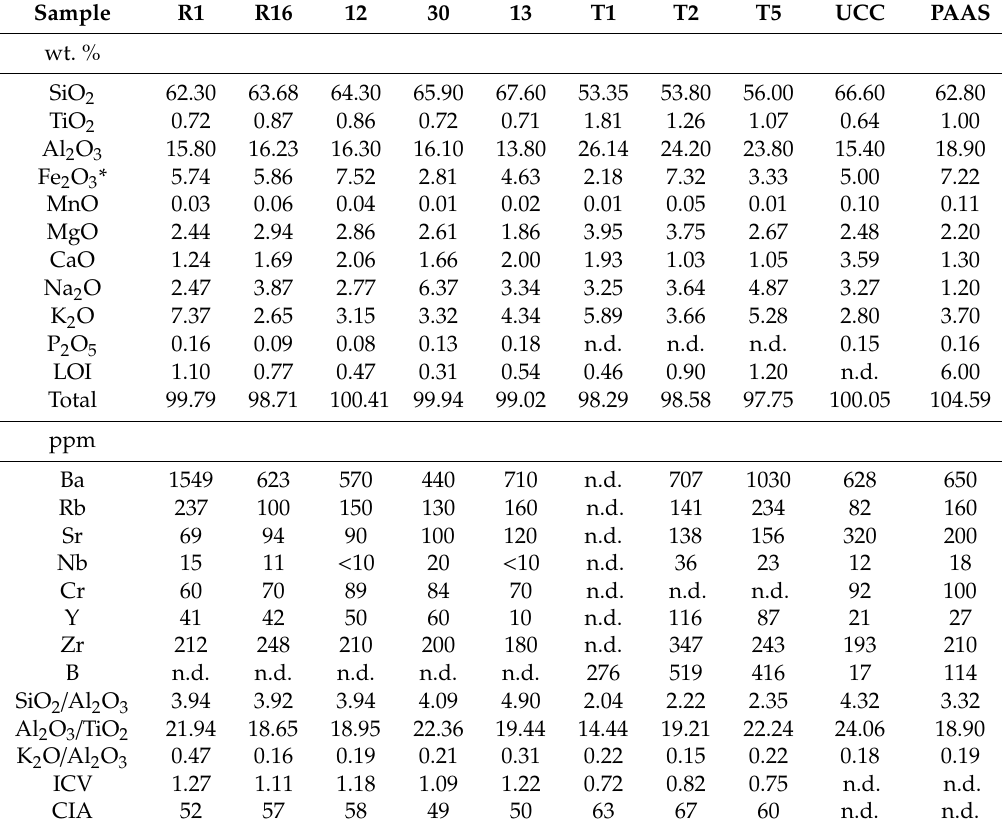
Table1. Geochemicalcompositionofkornerupine-bearingbiotitegneissfromtheNewJerseyHighlands.